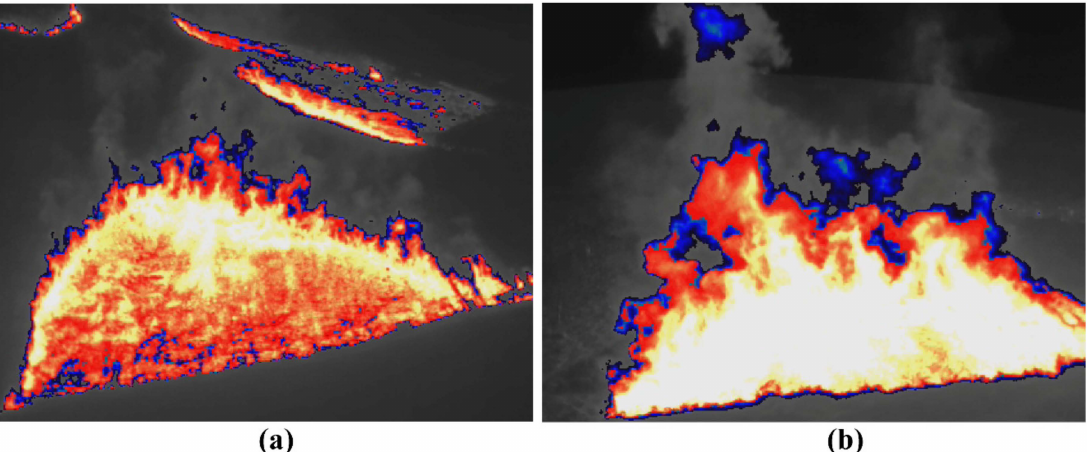
Figure 9. IR images captured from overhead drones during fire front propagation of the experimental fires performed in: ( a ) October 2021; ( b ) March 2022. Numerical representations of the fire propagation obtained using Firestar3D showed almost the same curved head shapes (Figure 10), considering a limited fire front width with open boundary conditions on the two lateral sides, as was the real case during these two experimental